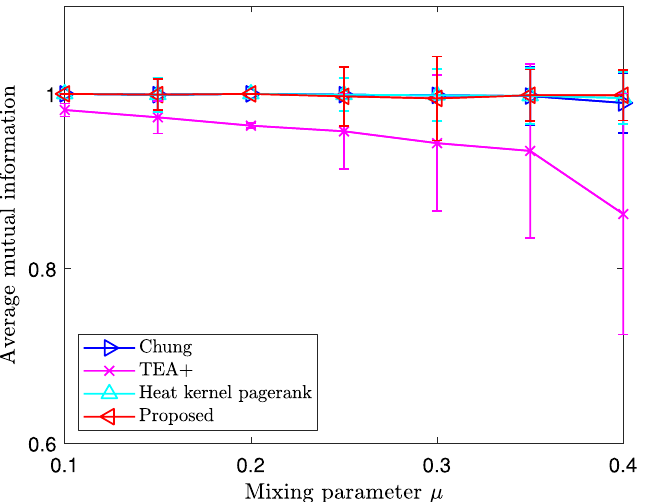
Figure 4. Average mutual information of local clusters estimated by different local clustering methods with benchmark communities in the Lancichinetti–Fortunato–Radicchi benchmark. Vertical error bars represent standard